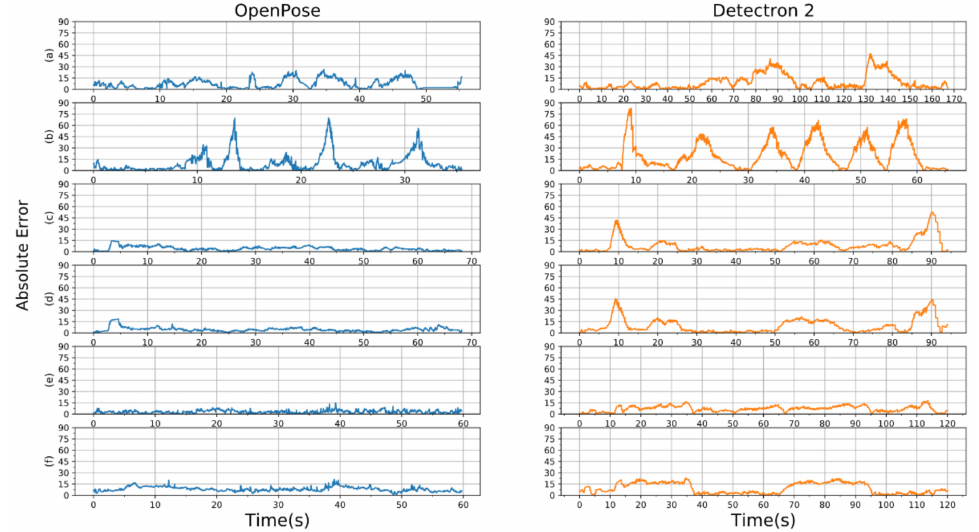
Figure 11. Absolute error for the four rehabilitation exercises compared to ground truth: ( a ) flexion side left elbow, ( b ) flexion left elbow, ( c ) abduction left shoulder, ( d ) abduction right shoulder, ( e ) extension left shoulder, and ( f ) extension right